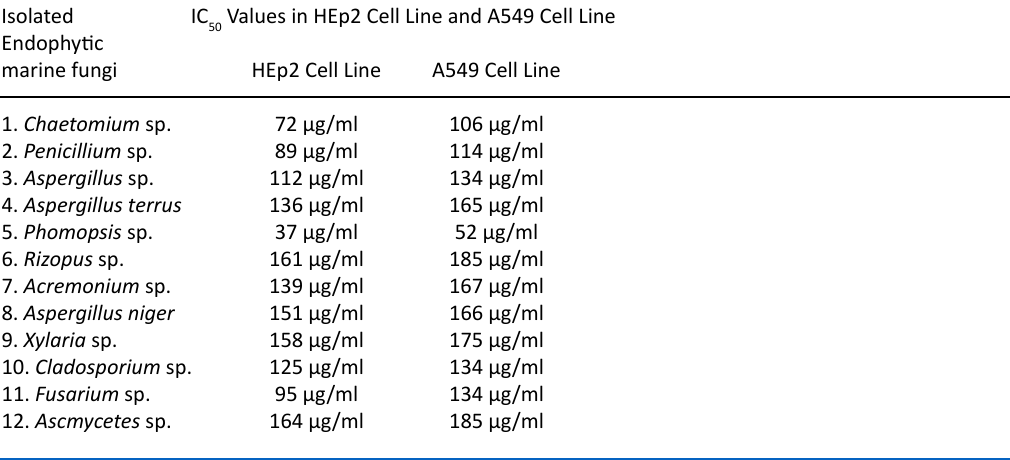
) of crude Ethyl acetate 50